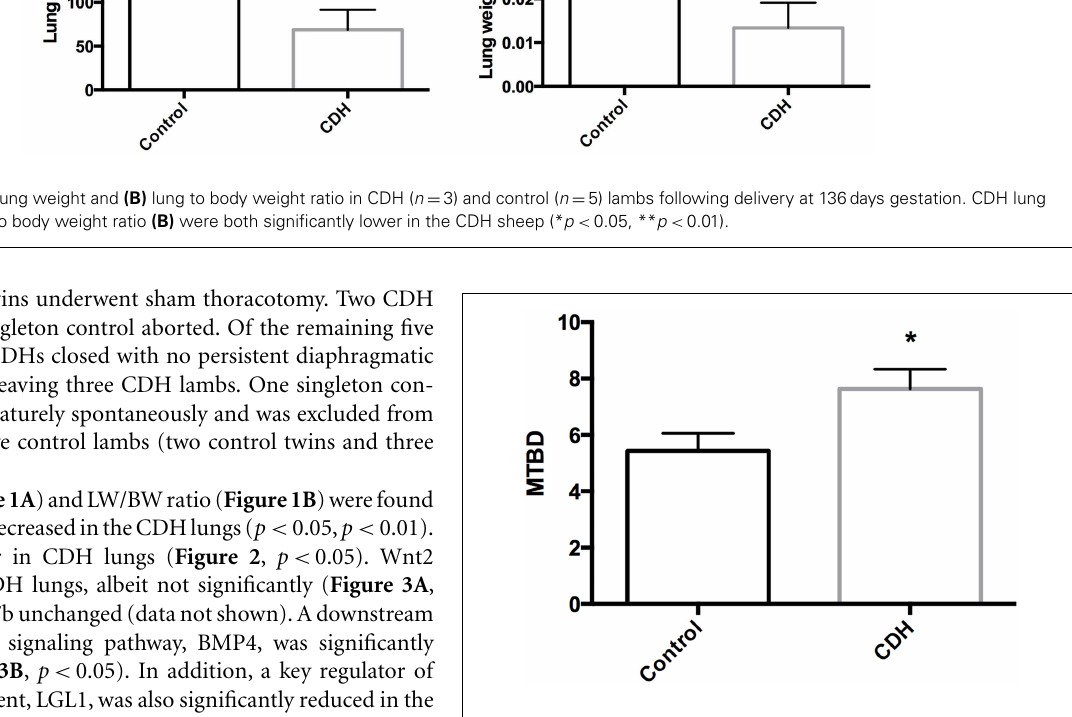
FIGURE 2 | Mean terminal bronchiole density in CDH lungs and controls . MTBD was significantly higher in control ( n = 5) compared with CDH ( n = 3) lungs (* p <